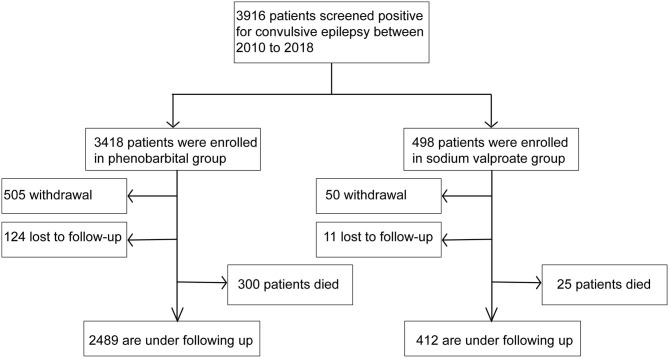
Follow-up survey and causes of death.